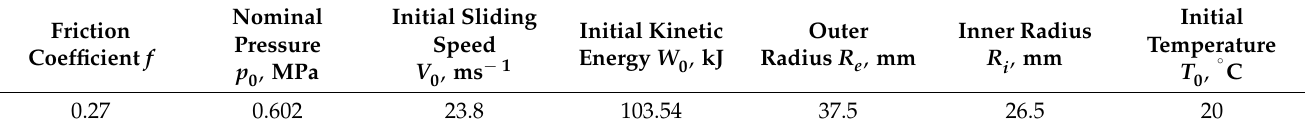
Table 1. Input parameters.